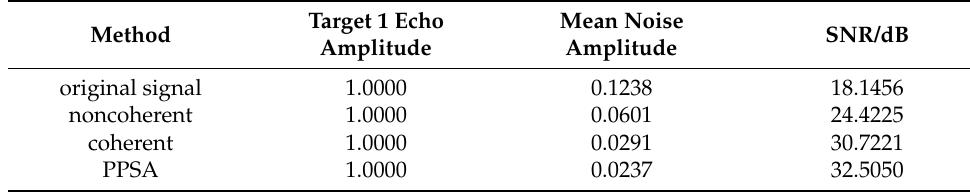
Table 5. SNR comparison of target 1.